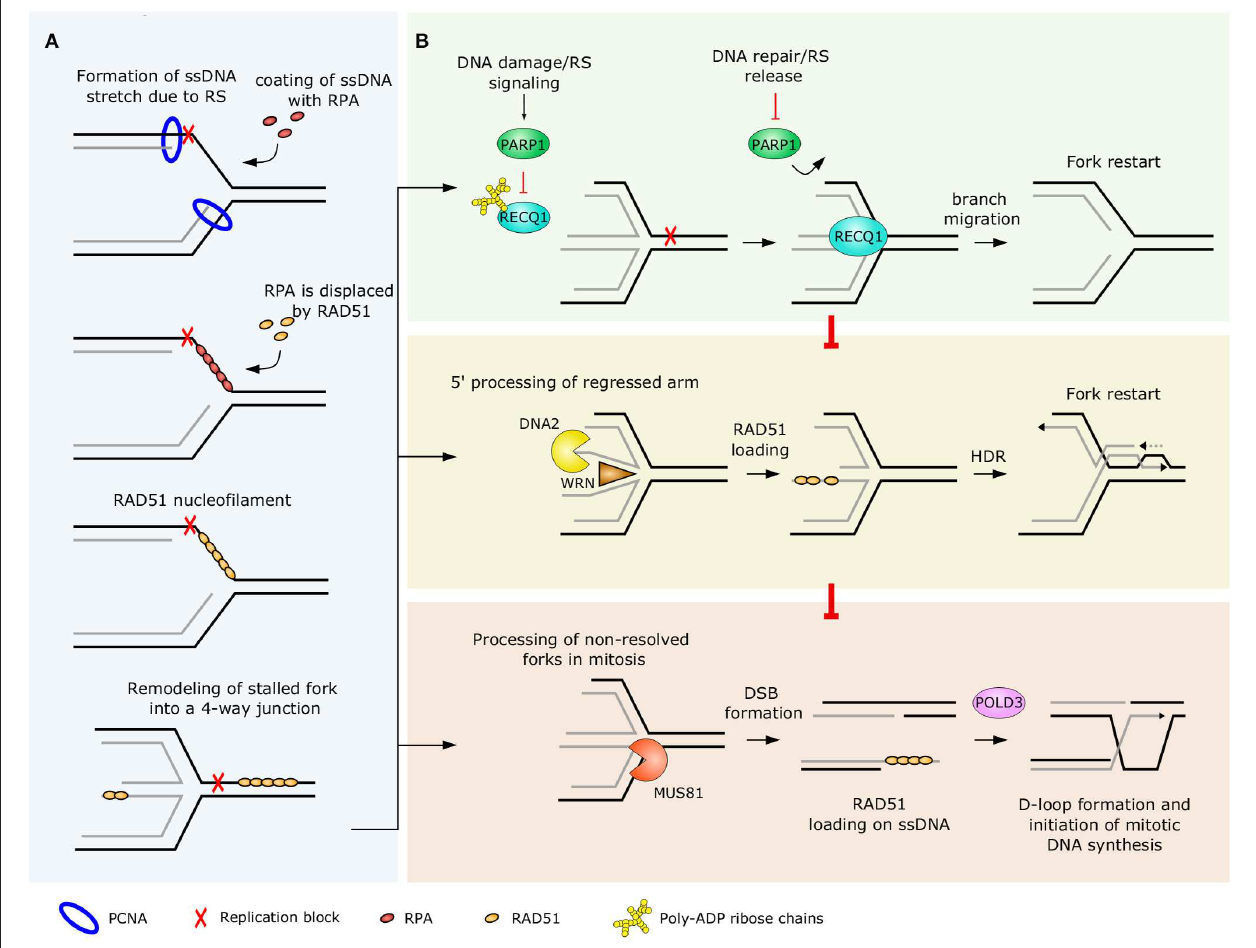
FIGURE 2 | RAD51-mediated RF reversal (A) and an overview of replication fork restart mechanisms (B) . (A) At stalled replication forks, ssDNA tracks are protected and coated with RPA. The DNA recombinase RAD51 replaces RPA and binds to DNA, contributing to the remodeling of the stalled fork into a reversed fork (4-way) structure. Besides RAD51, there are other replication fork remodelers, mentioned in the main text, but for simplicity only RAD51 is represented in this figure. (B) PARP1-mediated suppression of RECQ1 helicase is an important regulator of a premature restart of reversed forks (upper panel). Because of the least amount of processing involved, RECQ1-mediated pathway represents the first-choice restart mechanism of reversed forks. DNA2/WRN-driven restart involves regulated processing of the regressed arms and uses HDR to resolve the replication intermediate (middle panel). Reversed forks that could not be restarted in S phase are processed by MUS81 endonuclease later in mitosis and DSB break is formed in the process. The collapsed fork is then rescued by POLD3-driven D-loop formation and synthesis re-initiation (lower panel). PCNA, proliferating cell nuclear antigen; RPA, replication protein